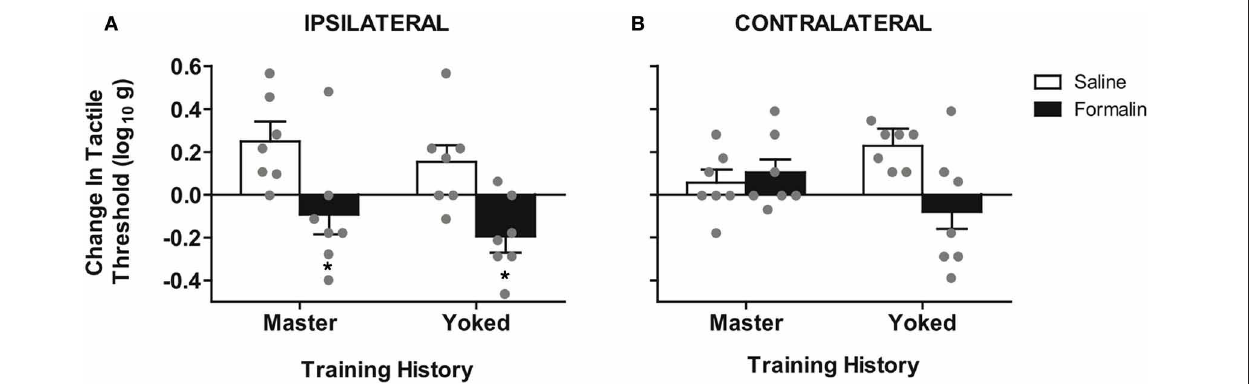
FIGURE 4 | Spinal training history alters formalin hyper-reactivity contralateral to the injection. (A) Significant hyper-reactivity response to formalin but no differential effect of master/yoked training history on the ipsilateral leg, ∗ p < 0 . 05 from saline, n = 7 rats/group. There was also no significant difference between master/yoked/unshocked on ipsilateral hyper-reactivity, all p > 0 . 05, (compare to Figure 3B ). (B) Significant enhancement of formalin hyper-reactivity in yoked group contralateral to injection, ∗ p < 0 . 05 from yoked saline, n = 7 rats/group. Bars represent group means ( ± SEM) gray points reflect the individual animals. Four-Way